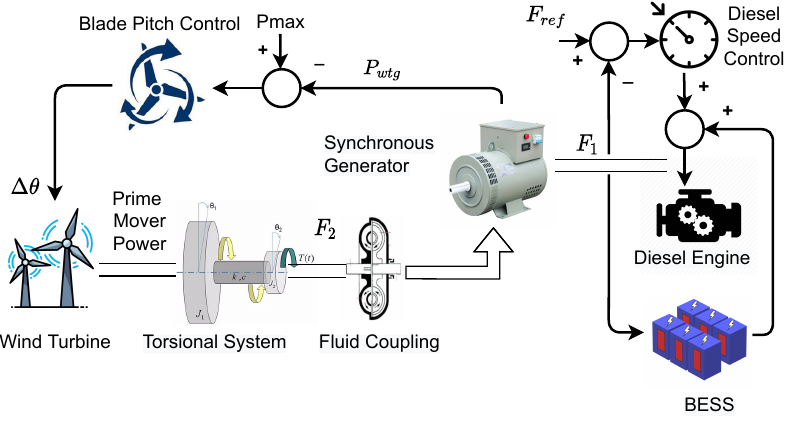
Figure 1. The general configuration of the mechanically coupled wind–diesel